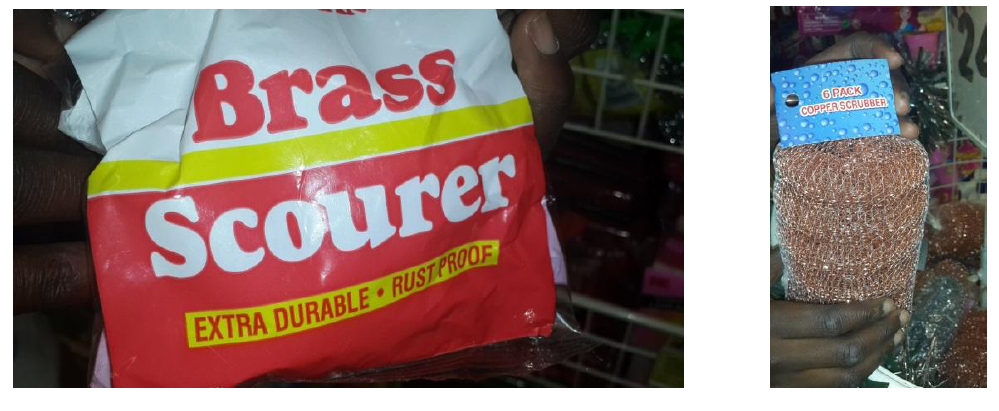
Figure 4. Cleaning materials containing copper and